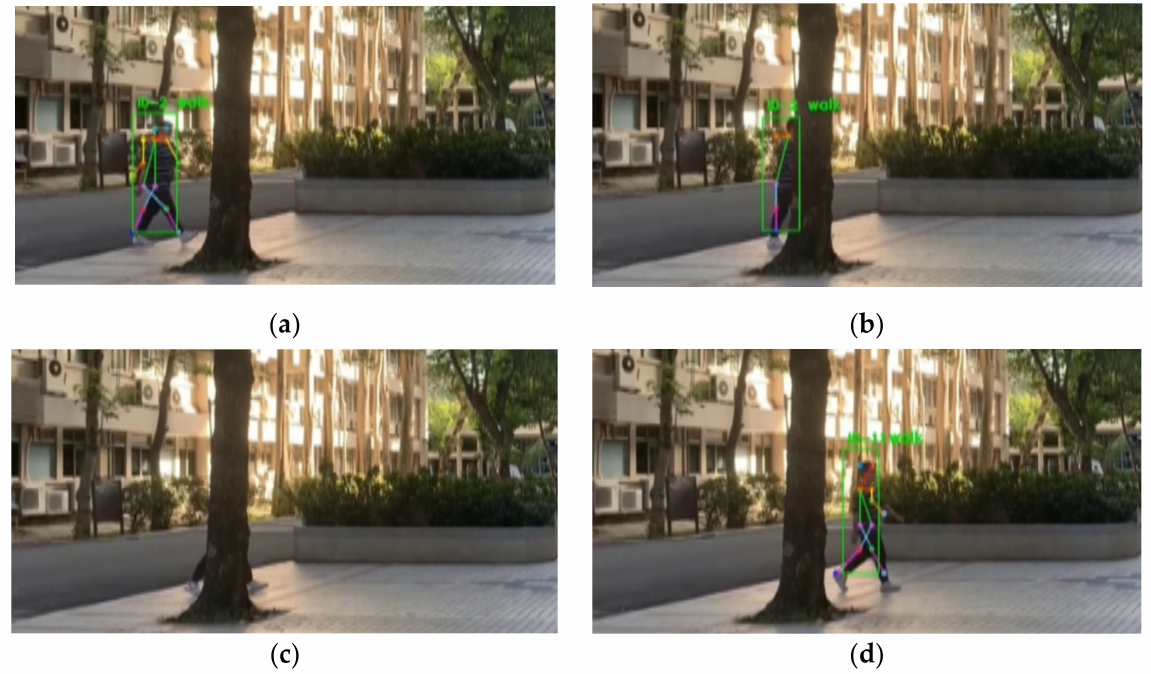
Figure 21. Outdoor posture recognition and tracking upon occlusion as: ( a ) Walk before occlusion; ( b ) Partial occlusion; ( c ) Full occlusion; ( d ) Walk out of